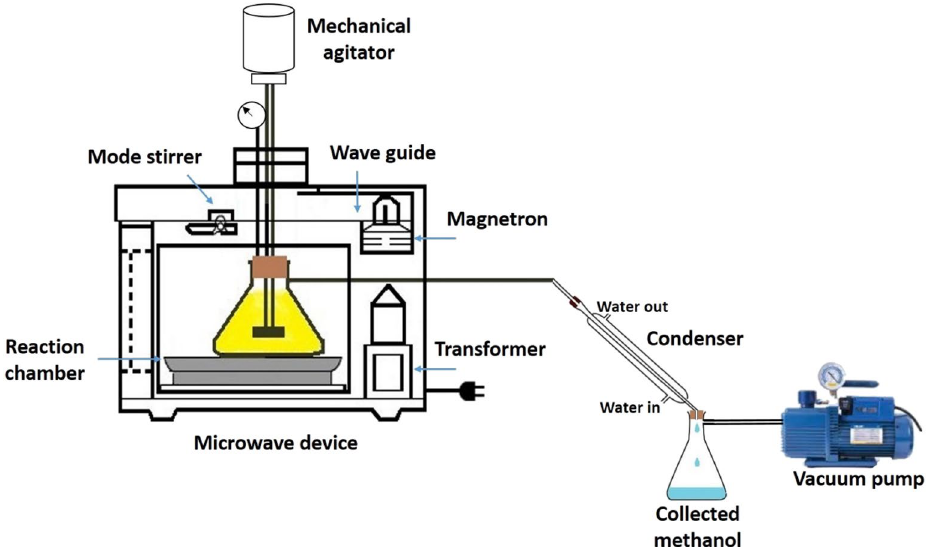
Figure 2. The experimental setup.